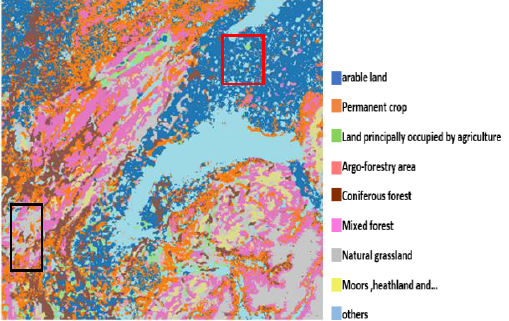
Figure 13. Classification map obtained from ResNet152 at 20 m spatial resolution with